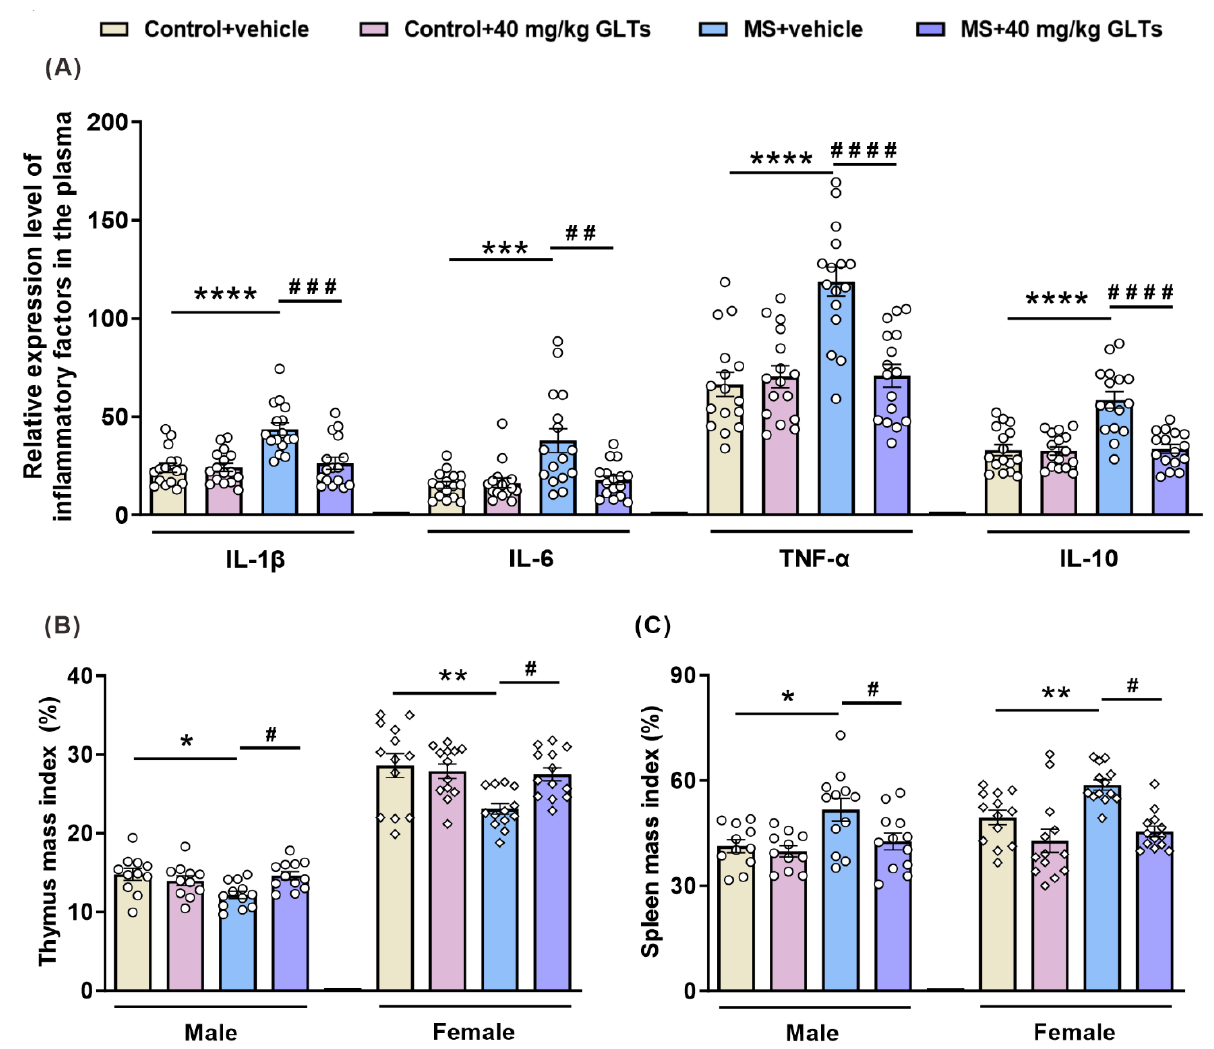
Figure 3. The reduced peripheral inflammatory response in MS mice by GLTs treatment. ( A ) IL- 1 β , IL-6, TNF- α , and IL-10 level in the periphery of mice. Data are expressed as mean ± SEM, n = 16/group. ( B ) The thymus mass index of the male and female mice. ( C ) The spleen mass index of the male and female mice. Data are expressed as mean ± SEM. Male: Control + vehicle group, n = 11; Control + GLTs (40 mg/kg) group, n = 11; MS + vehicle group, n = 12; MS + GLTs (40 mg/kg) group, n = 12. Female: n = 13/group. * p < 0.05, ** p < 0.01, *** p < 0.001, **** p < 0.0001, as compared with Control + vehicle group; # p < 0.05, ## p < 0.01, ### p < 0.001, #### p < 0.0001, as compared with MS